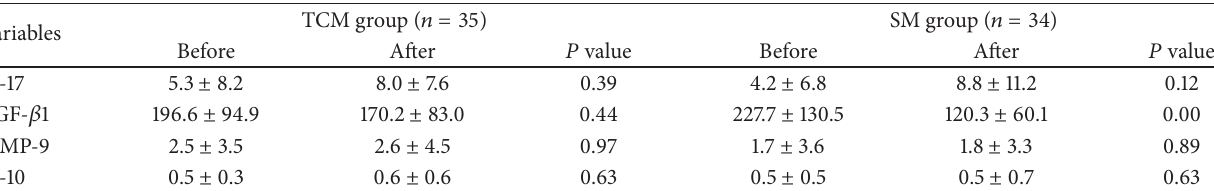
Table 3: Comparison of the mRNA expression levels of IL-10, IL-17, TGF- 𝛽 1, and MMP-9 in the TCM and SM groups before and after treatment (mean ± SD).